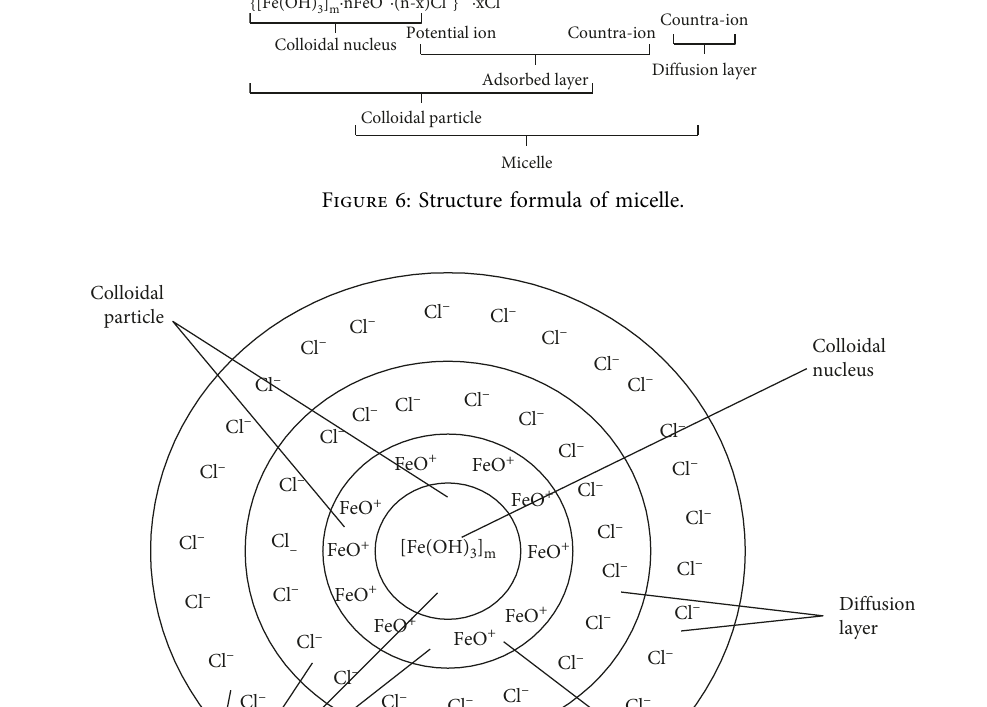
3 micelle structure.